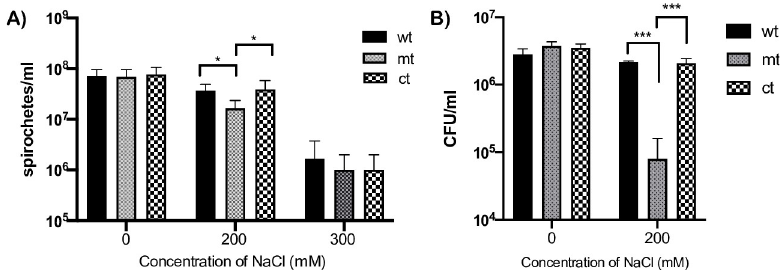
Fig 11. Sensitivity of bpiP mutant to osmotic stress. All three strains (wt, mt or ct) were seeded at a density of 1x10 6 spirochetes per ml in 5 ml of normal BSKII or BSKII supplemented with 200 or 300 mM of sodium chloride. (A) Cultures were incubated at 32˚C, enumerated every 24 hours and number of spirochetes/ml at 5 days post-treatment is shown. (B) Colony forming units of cultures with 0 or 200 mM concentration of sodium chloride at day 5 post- treatment were determined by diluting cultures of all three strains to 1:100,000 in 1X BSKII medium, plated on BSKII agar overlays and the final CFU/ml of the treated cultures were calculated after 10 days of incubation at 32˚C with 1% CO 2 . Data shown are means of three technical replicates with error bars representing Standard Error Mean and is representative of one of the three experiments. Statistical analysis was done using unpaired t -test and the asterisks indicate levels of significance as follows: ��� , p < 0.001; � , p < 0.05.